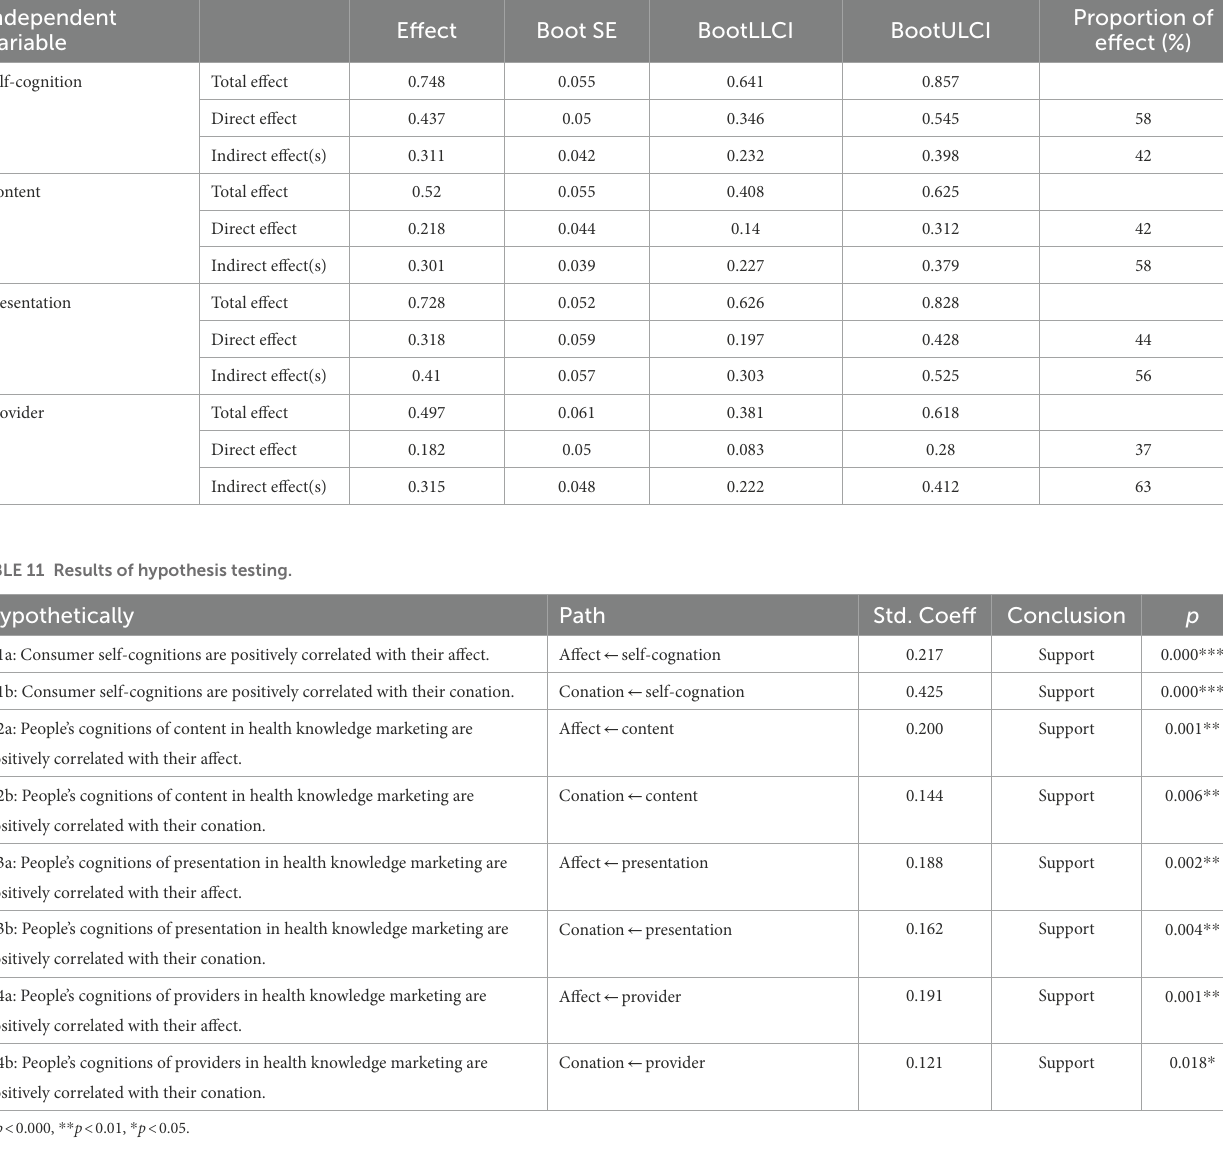
TABLE 10 Total effect, direct effect and intermediate effect breakdown table.